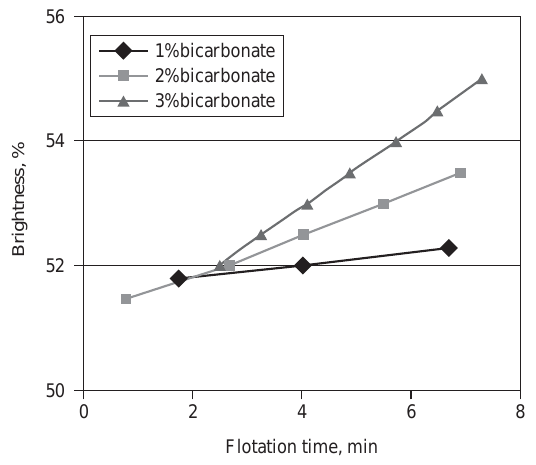
Fig. 6 Effect of Flotation time on deinked pulp Brightness (1% H 2 O 2 , 2 minutes pulping time, different bicarbonate dosages)